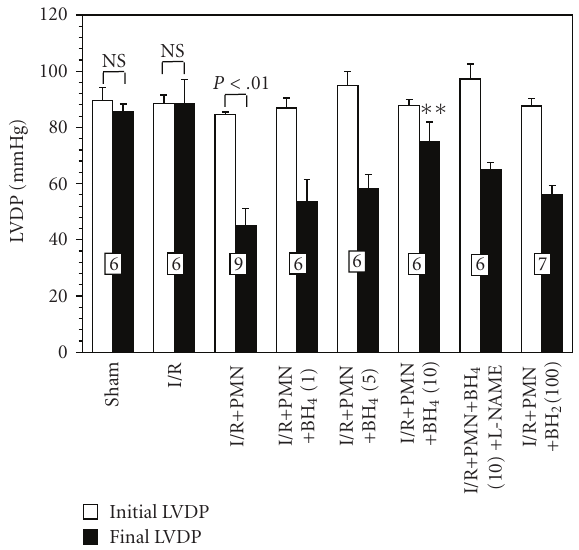
Figure 5: Initial and final LVDP expressed in mmHg from di ff erent experimental groups. Hearts were perfused in the presence or absence of PMNs. PMNs induced a significant decrease in LVDP, which was attenuated by the BH 4 (10 μ M), not by BH 2 (100 μ M). L-NAME (50 μ M) blocked the cardioprotective e ff ect of BH 4 treatment. All values are expressed as mean ± SEM. Numbers of hearts are at the bottom of the bars. All drugs are in μ M concentrations. ( ∗∗ P < . 01 from final I/R+PMN values; NS, not significant compared to initial LVDP